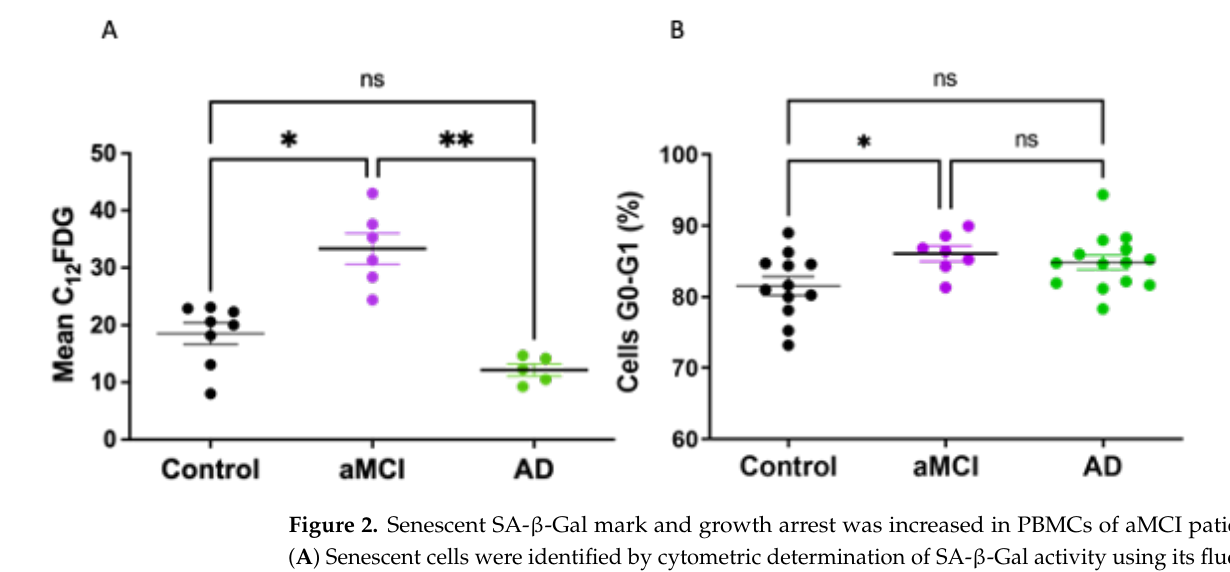
Figure 2. Senescent SA- β -Gal mark and growth arrest was increased in PBMCs of aMCI patients. ( A ) Senescent cells were identified by cytometric determination of SA- β -Gal activity using its fluo- rescent substrate C12FDG. SA- β -Gal activity was significantly increased in PBMCs of aMCI pa- tients (n = 6) compared with healthy controls (n = 8), while AD PBMCs (n = 5) had levels similar to controls. ( B ) Growth arrest of PBMCs was determined by the percentage of cells at cell-cycle stage G0/G1 by cytometric determinations with propidium iodide staining. The percentage of PBMCs arrested at G0-G1 in aMCI patients (n = 7) was increased in comparison with healthy controls (n = 12), whereas no change was seen in AD PBMCs (n = 14). Statistical analysis: Kruskal – Wallis with Dunn’s post hoc correction, * p < 0.05, ** p < 0.01 for ( A , B ), ns = non-significant.